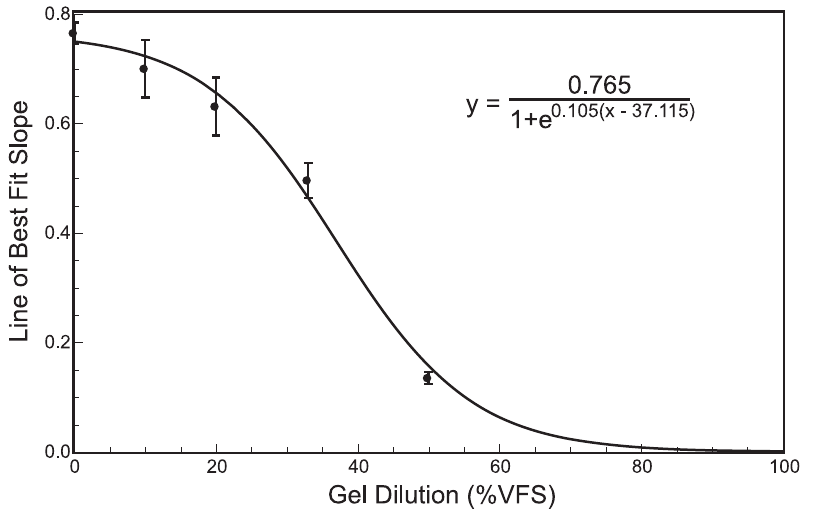
Figure 3. Line of best fit slope (from weighted total linear regression in Fig. 2) plotted against gel dilution (% VFS). The sigmoid fit was determined with a logistic 4-parameter analysis, and the resultant equation is displayed in the figure.